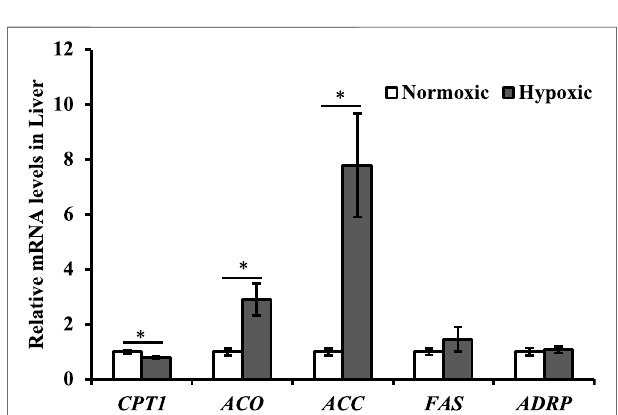
FIGURE 7 | Effect of acute hypoxic stress on the expression of the autophagy-related genes in the liver of triploid rainbow trout ( n = 6; LC3 β , microtubule associated protein 1 light chain 3 beta; gabarapL1, gamma aminobutyric acid receptor-associated protein; atg4b, autophagy- related 4 β ; atg12L, autophagy-related 12L). Asterisks indicate signi fi cant differences ( t -test; * p < 0.05; ** p <